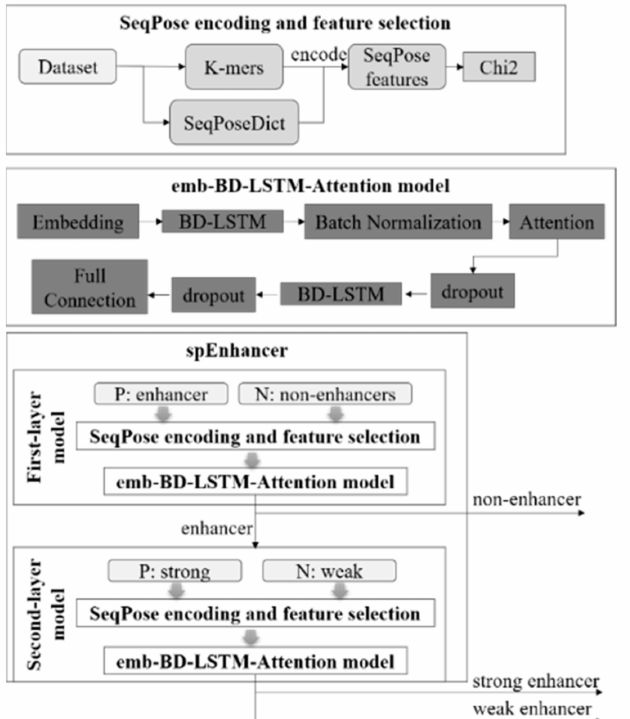
Figure 5. Workflow of the proposed two-layer model spEnhancer. A schematic diagram depicting the steps of feature extraction, feature selection, and